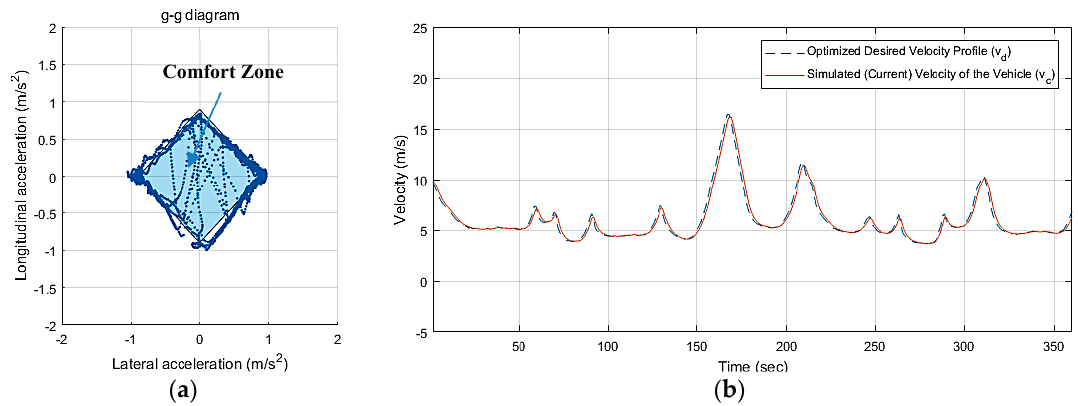
Figure 9. Simulation results of the path following control with the proposed optimized velocity planning which is set by Table 1 parameters, ( a ) GG diagram and ( b ) velocity profiles during SIL test.